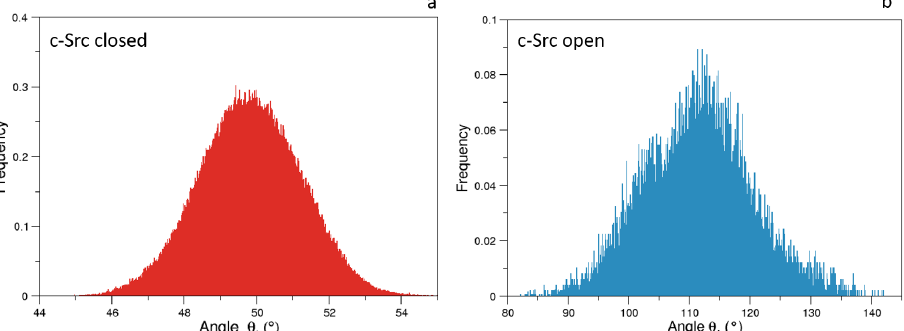
Figure 7. Normalized distributions of the angle θ K 23 for the closed (panel a ) and open state (panel b ).